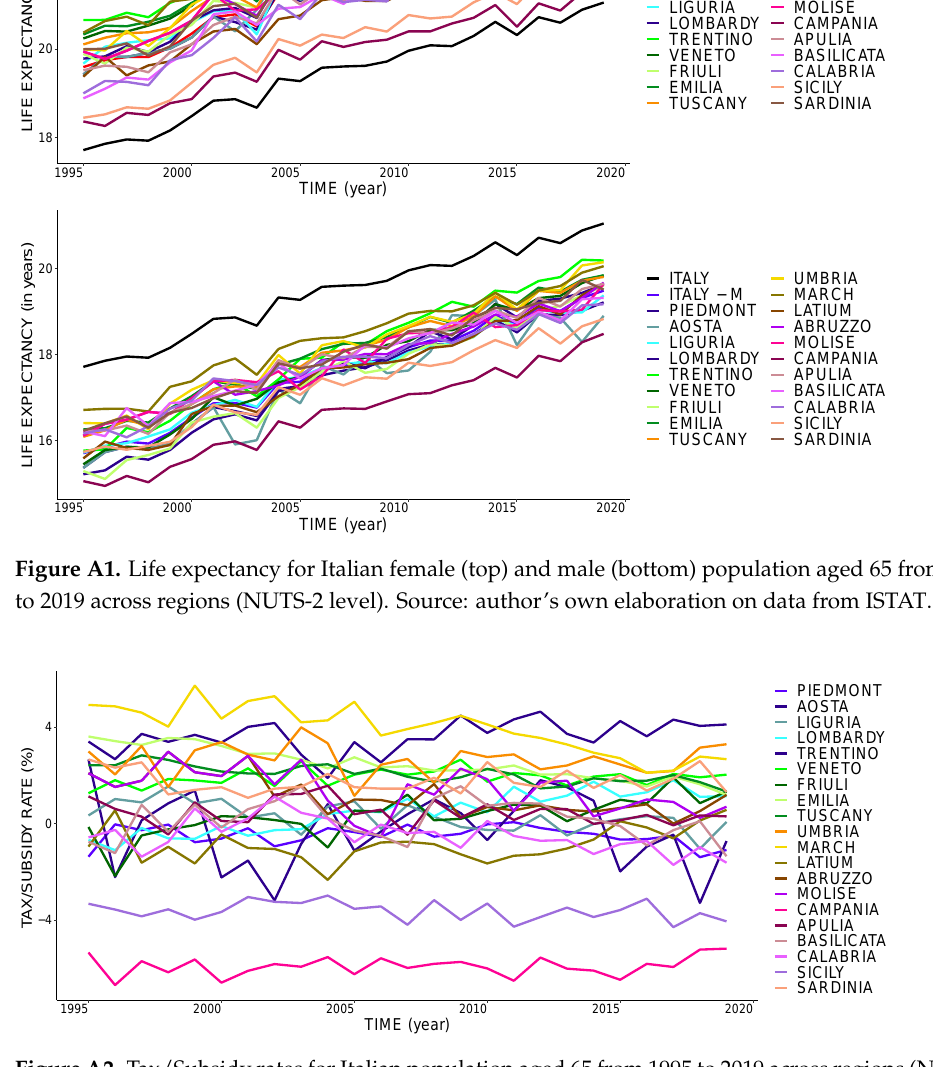
Figure A2. Tax/Subsidy rates for Italian population aged 65 from 1995 to 2019 across regions (NUTS-2 level). Source: author’s own elaboration on data from